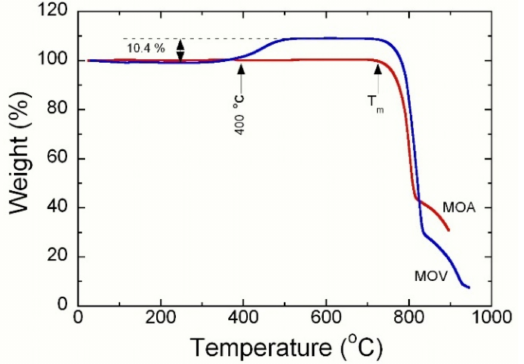
Figure 3. Thermogravimetry (TG) curves of the MOA and MOV samples recorded at a heating rate of 10 ◦ C min − 1 . MOA displays the typical behavior of the stoichiometric MoO 3 orthorhombic phase, while MOV shows the oxidation of the suboxide at 400 ◦ C and the conversion to MoO 3 at 600 ◦ C.